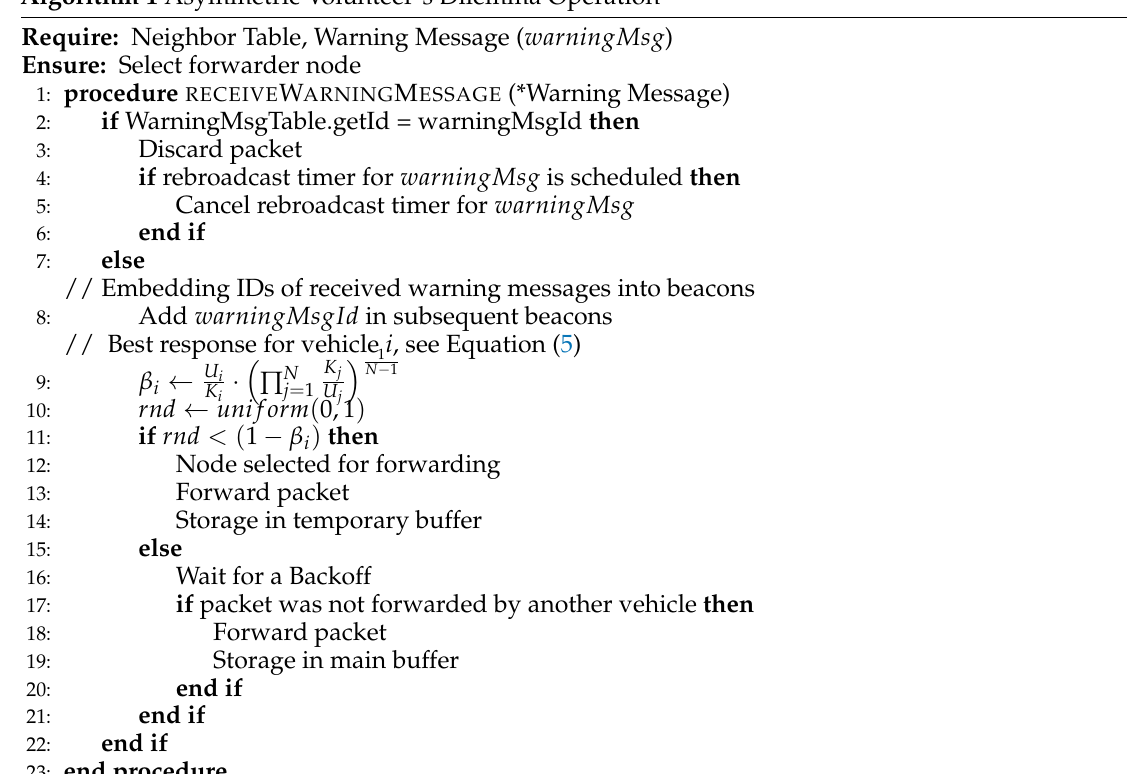
Algorithm 1 Asymmetric Volunteer’s Dilemma